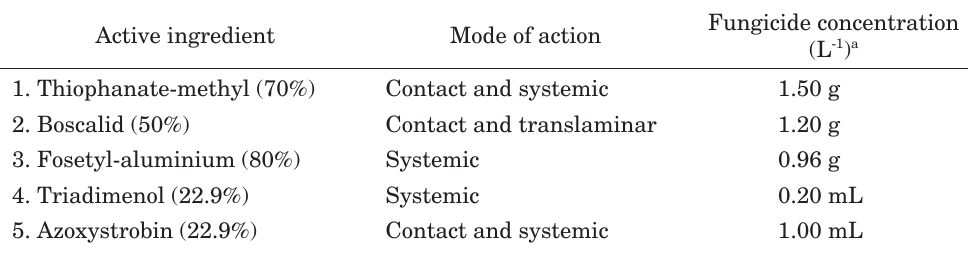
Table 1. Fungicides assessed for control of S. cardinale cypress canker and used in in vitro trials and in tree sprayings. Concentration of the active ingredient in the commercial product is shown in parentheses. The product trade names are: 1. Enovit Metil ® Sipcam; 2. Cantus ® Basf; 3. Aliette ® Bayer; 4. Bayfidan ® Bayer; 5. Quadris ®